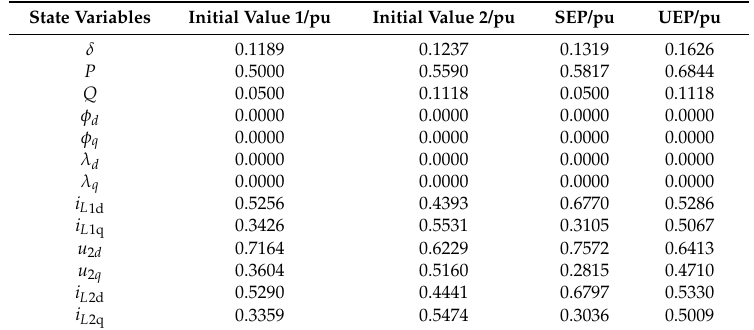
Table 2. Initial values and equilibrium points of test system 1.